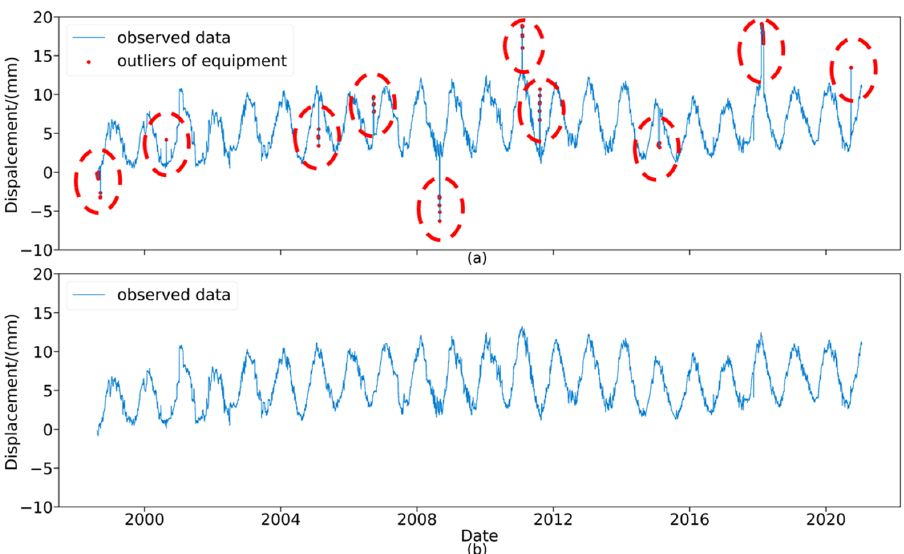
Figure 8. Dam horizontal displacement data collected from automated monitoring equipment: ( a ) the original data and ( b ) the data processed through DBSCAN. The basic stats of the original data and the data processed using the DBSCAN method